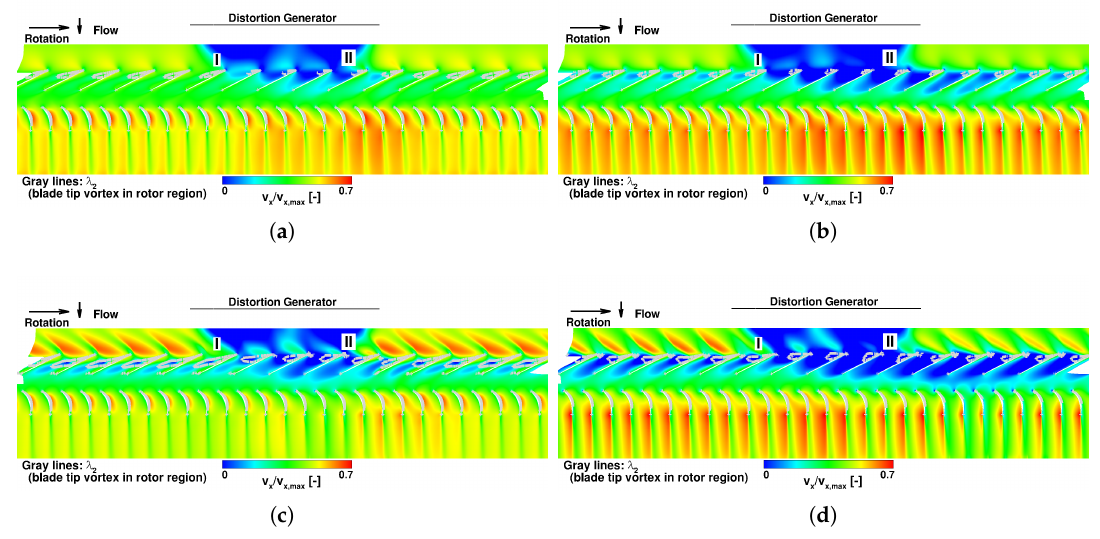
Figure 6. Axial velocity and blade tip vortices ( λ 2 -criterion) at 98% span. ( a ) N65, PE; ( b ) N65, NS; ( c ) N100, PE; ( d ) N100,